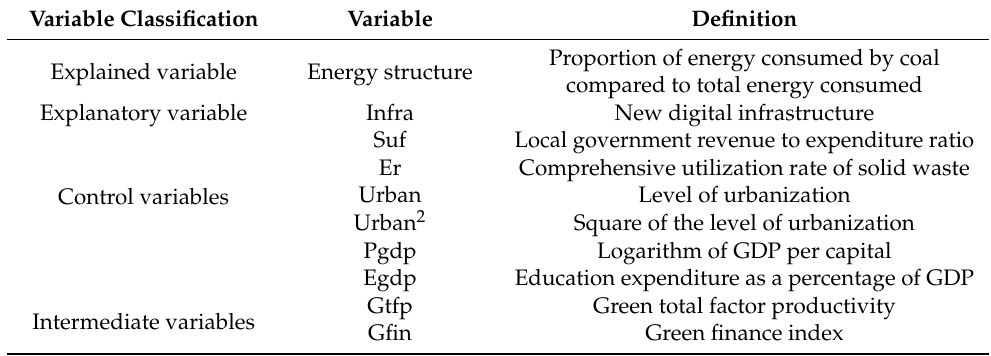
Table 2. Variable